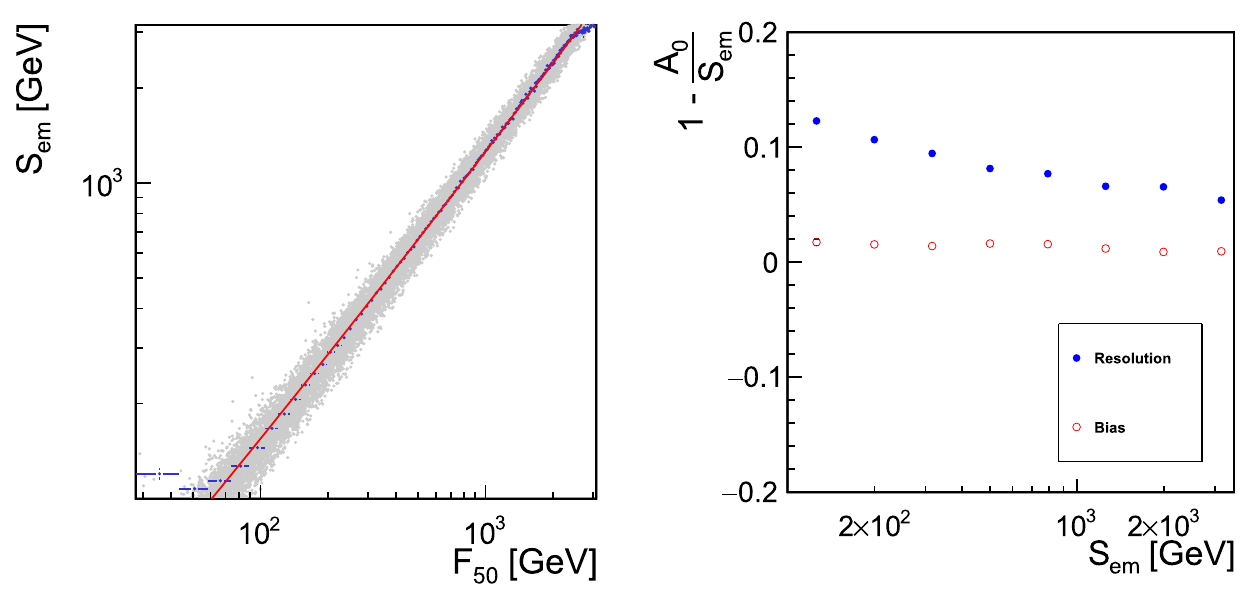
Fig. 2 Correlation of the electromagnetic energy deposited at the ground, S em , with F 50 , the energy deposited at the ground within a radius of50 mfrom the core position(see textfor the simulationdetails)